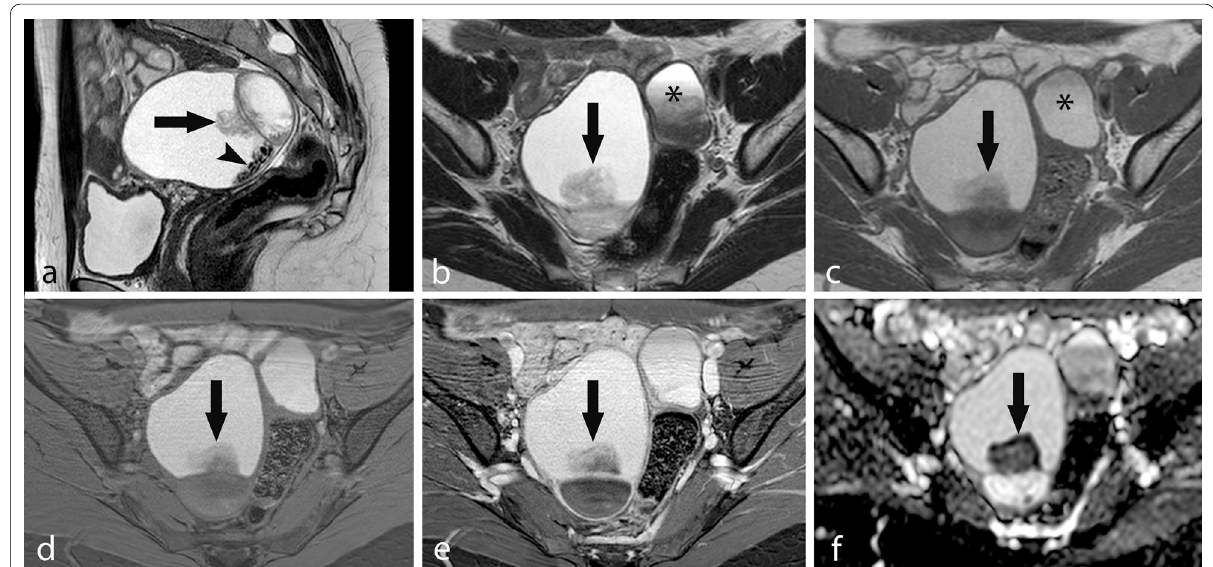
Fig. 5 Large OMA with irregular mural vegetation and dark spots. TSE T2w sagittal image ( a ), TSE T2w axial image ( b ), TSE T1w axial image ( c ), axial THRIVE image ( d ), contrast-enhanced axial THRIVE image ( e ) and ADC map ( f ). A large right multiloculated OMA is shown with an irregular mural vegetation (arrow) and small dark spots (arrowhead). The vegetation shows no significant contrast enhancement ( e ) but restricted diffusion ( f ) and should be considered suspected for malignancy. A smaller left-sided OMA with shading sign is also visible